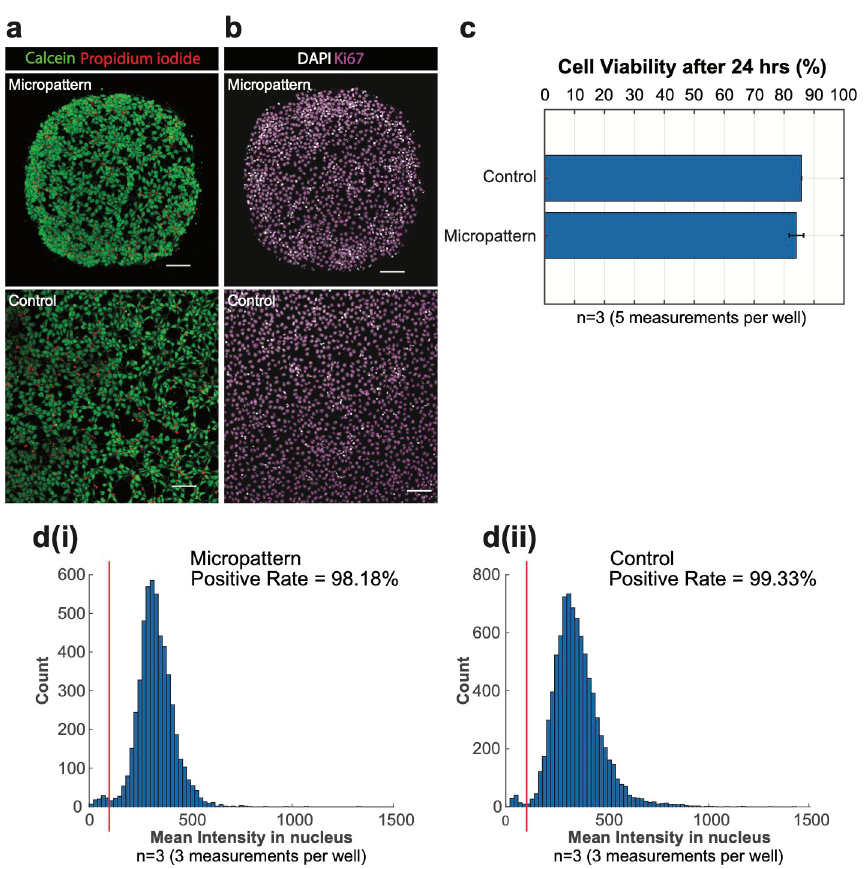
Fig 4. Cell viability and proliferation assessments after 24 hours. ( a ) Confocal images of live/dead staining of hESCs on LN521-coated micropatterned (top) or glass (bottom, control) surfaces with calcein-AM (live) and propidium iodide (dead) after 24-hour-culture. Scale bar = 100 μ m. Colony size: Diameter of 650 μ m. ( b ) Confocal images of hESCs immunostained for Ki67 on micropatterned (top) or bare glass (bottom, control) surfaces after 24-hour-culture. Scale bar = 100 μ m. Colony size: Diameter of 650 μ m. ( c ) The quantities of live and dead cells were quantified from the calcein-AM/PI staining images. Cell viability is calculated as a percentage of living cell (# of living cells/(# of living cells + # of dead cells). The results were reported as the mean ± standard deviation. P < 0.05. ( d ) Cell proliferation assessed by Ki67 assay was quantified and analyzed from Ki67 immunostaining images, and plotted as histograms (micropatterns in (i), and control in (ii)). The red line in each plot indicated the threshold used to calculate the Ki67 positive rate.